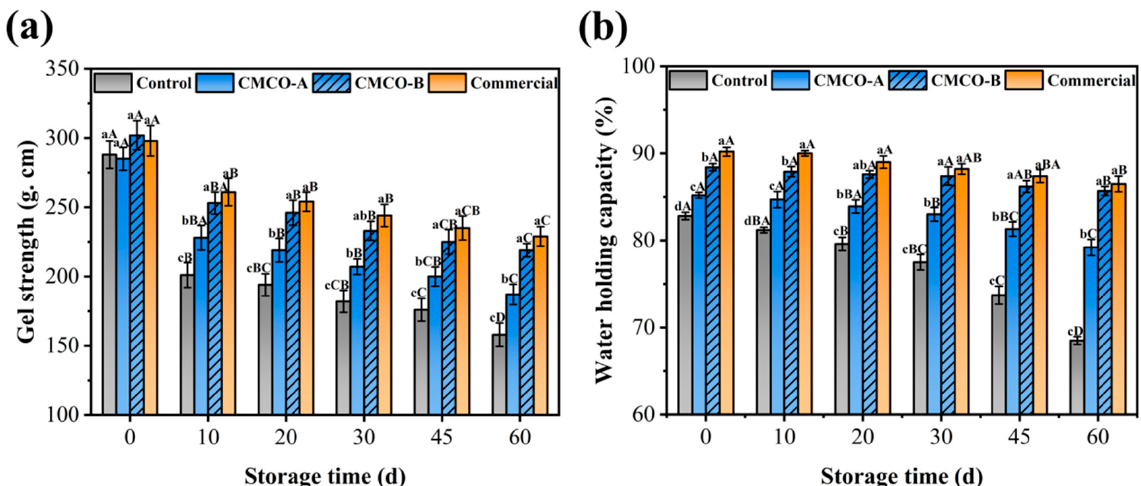
Figure 6. Effects of CMCO on the mechanical strength ( a ) and water-holding capacity ( b ) of the gels prepared from frozen surimi at different storage time. Values with different uppercase letters indicate statistically significant difference among samples with different cryoprotectants at the same storage time ( p < 0.05). Values with different lowercase letters indicate significant difference among samples with the same cryoprotectants at different storage time ( p < 0.05).